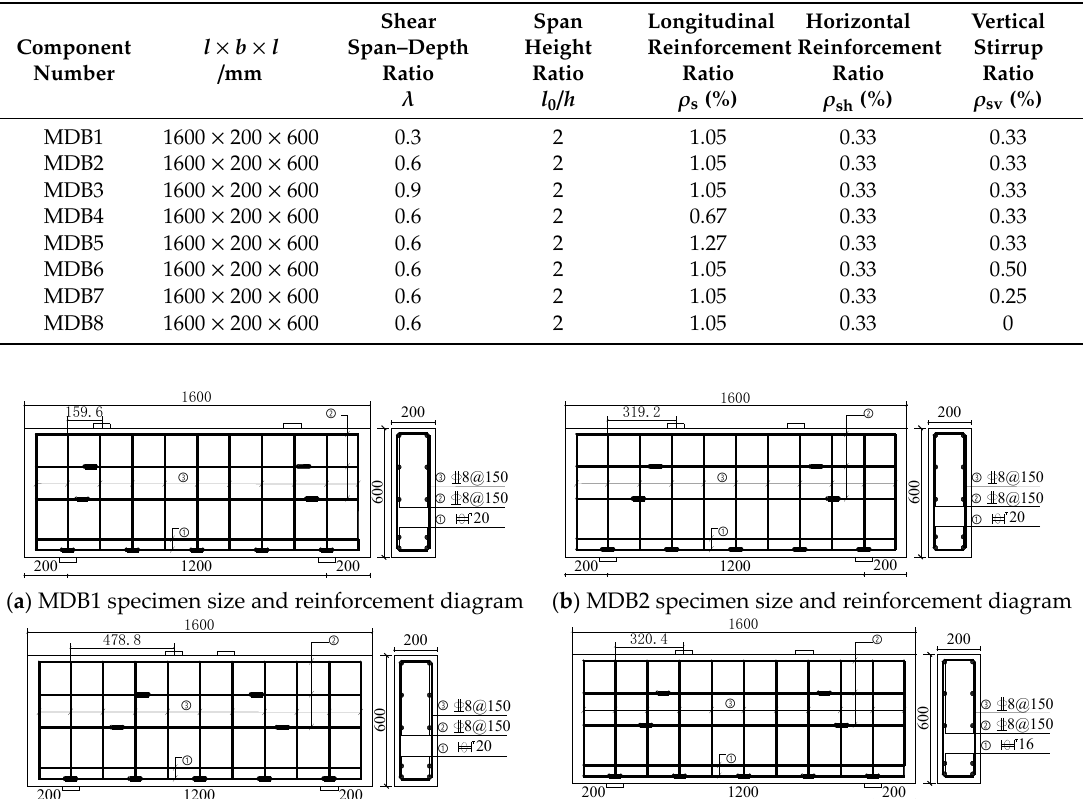
Table 3. Test specimen design parameters.